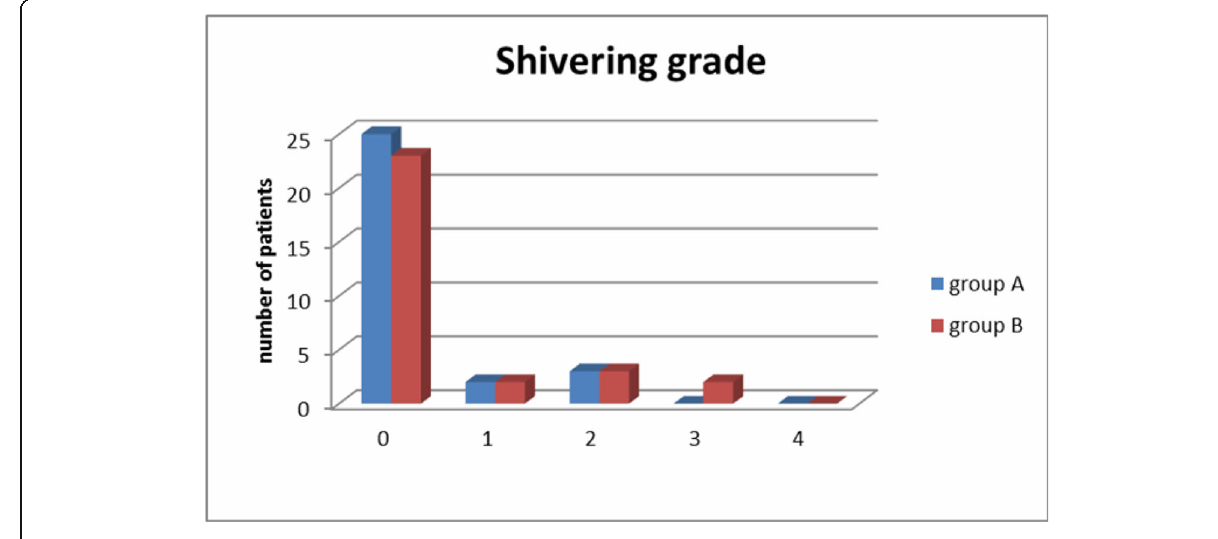
Table 9 Incidence of adverse effects Hypotension (No. of